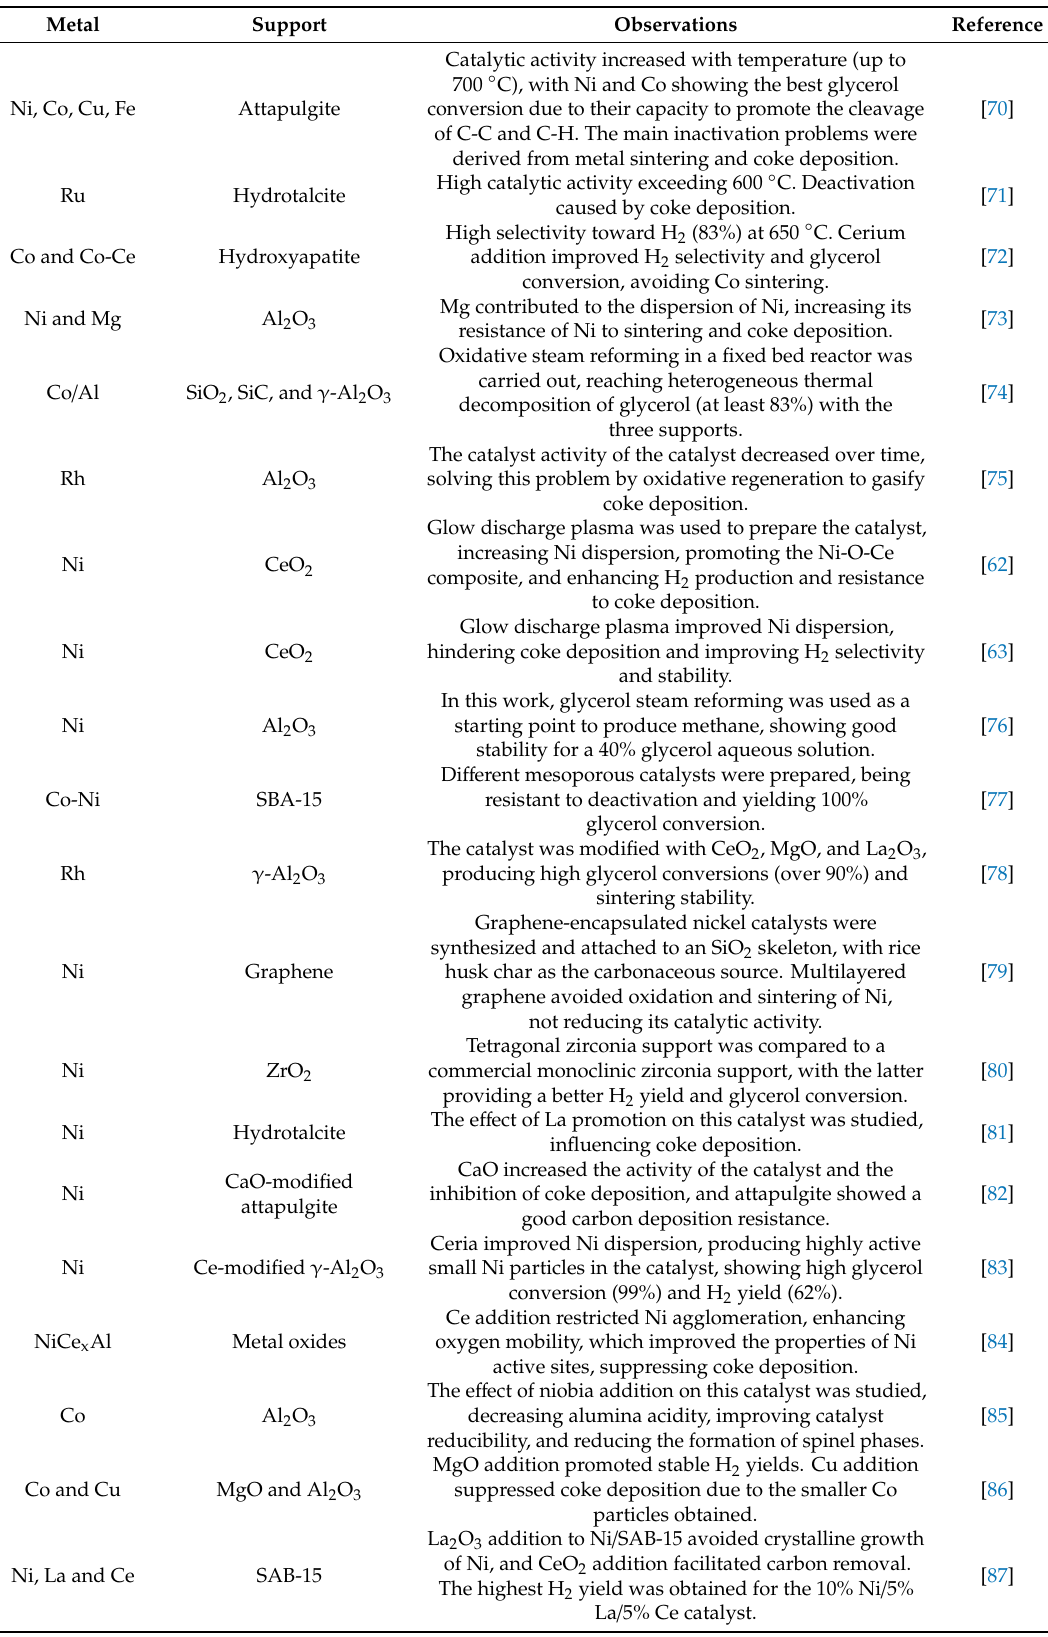
Table 3. Recent uses of catalysts in glycerol steam